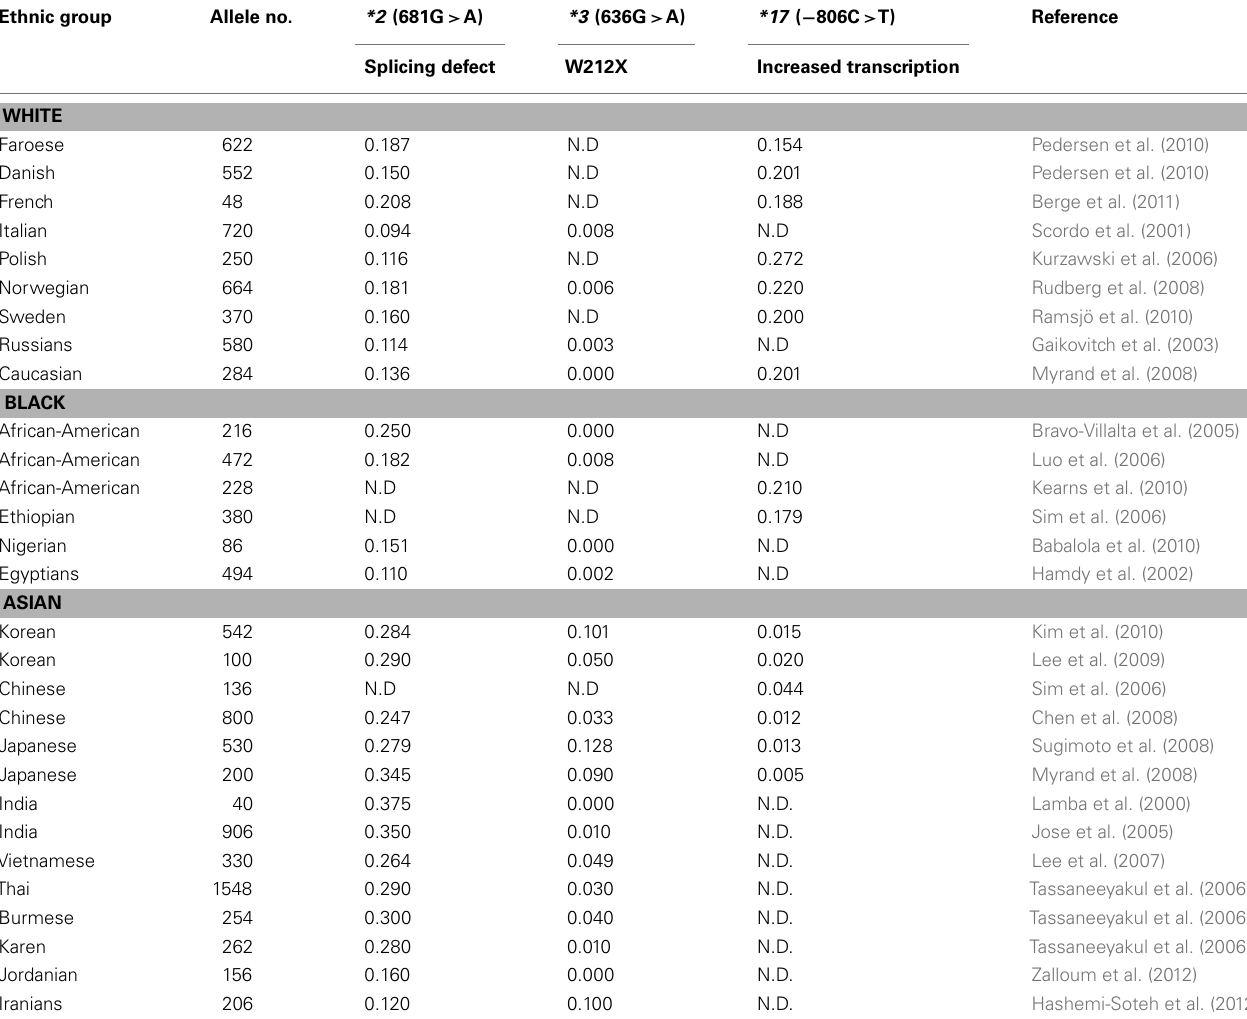
Table 1 | Frequencies of CYP2C19 * 2, * 3, and * 17 alleles in different ethnic populations. Ethnic group Allele